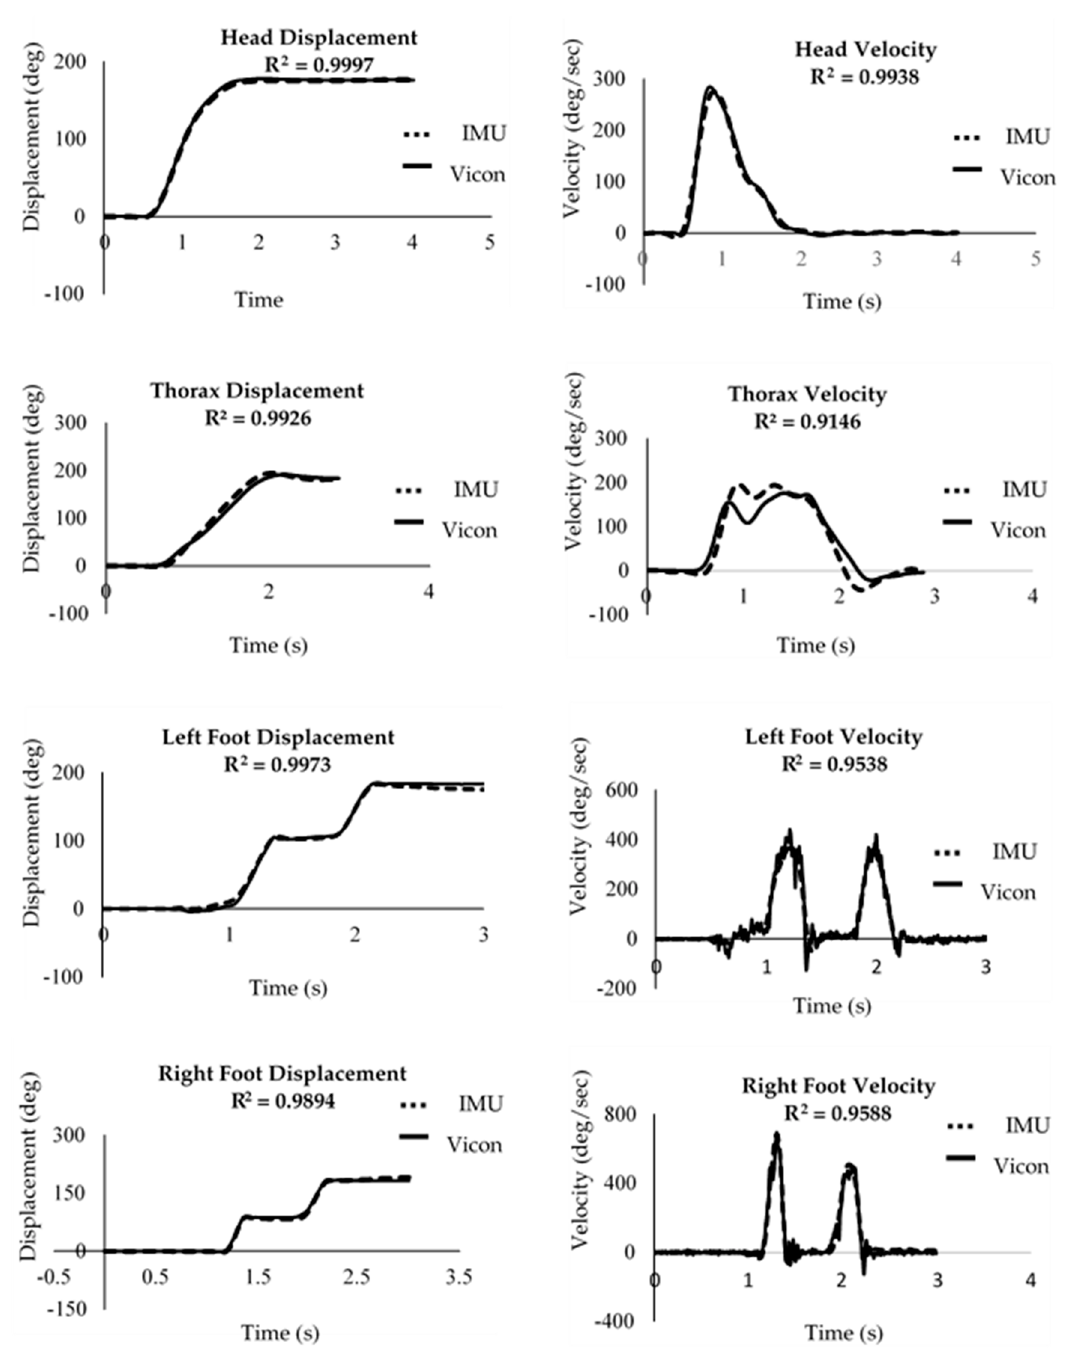
Figure 2. Examples of the angular displacement and velocity data collected during one trial. The solid lines represent data collected by the Vicon motion analysis system and the dotted lines the data collected by the IMU sensors.